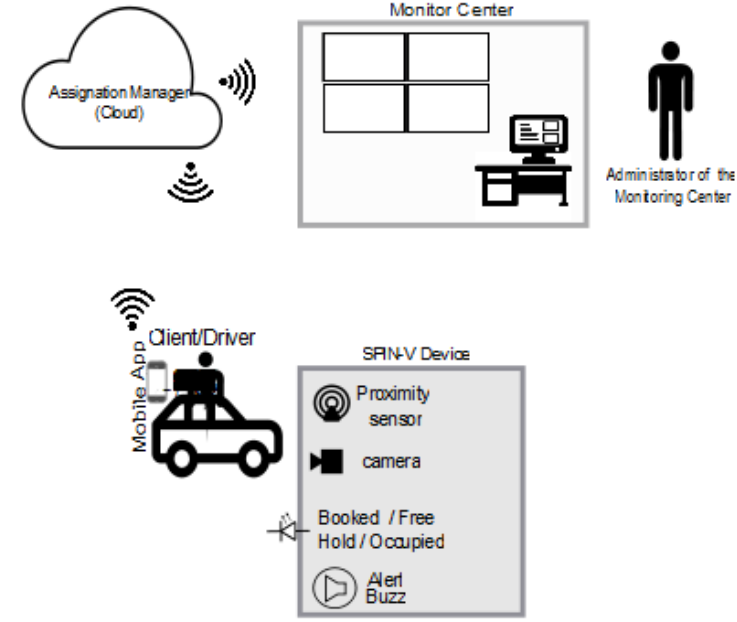
Figure 2. Network architecture of the SEI-UVM.